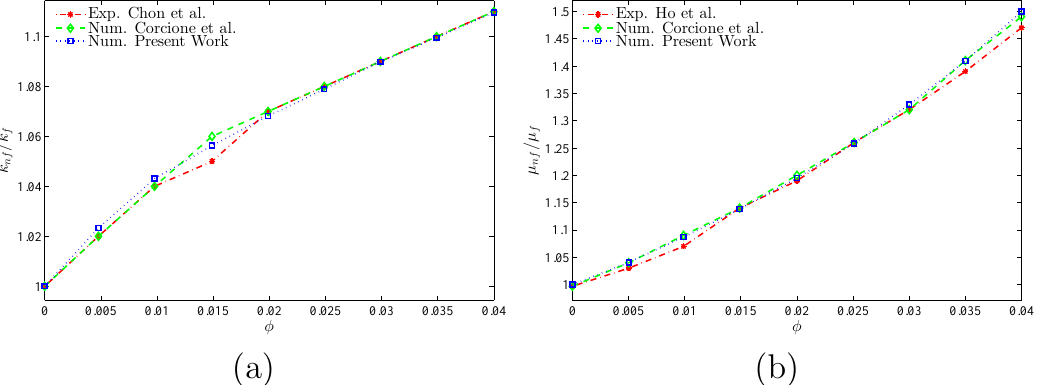
Figure 5. Comparisons of: ( a ) thermal conductivity ratio between the current numerical results, Chon et al. [46] (experimental), and Corcione et al. [41] (numerical); and ( b ) dynamic viscosity ratio of the current results with Ho et al. [43] (experimental) and Corcione et al. [41] (numerical) at Ra = 3.37 × 10 5 , N = 0, and R =